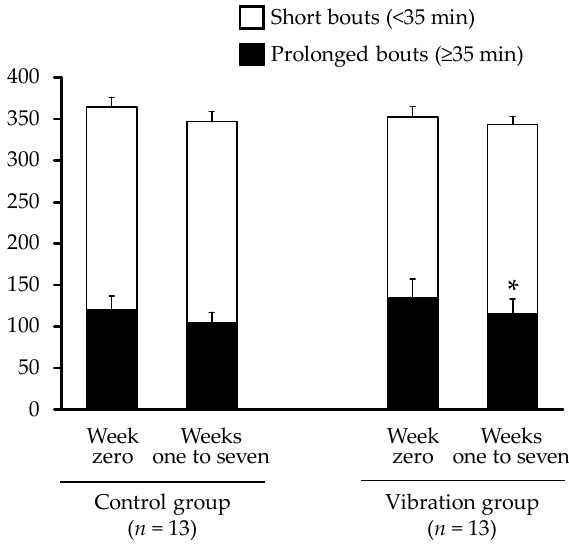
Figure 4. Changes in prolonged ( ≥ 35 min) and short ( < 35 min) bouts of sedentary time from week zero to weeks one to seven. Each data point represents mean value for all participants, with missing data replaced by baseline observation carried forward. Error bars indicate standard error. * p < 0.05 for within-group differences.